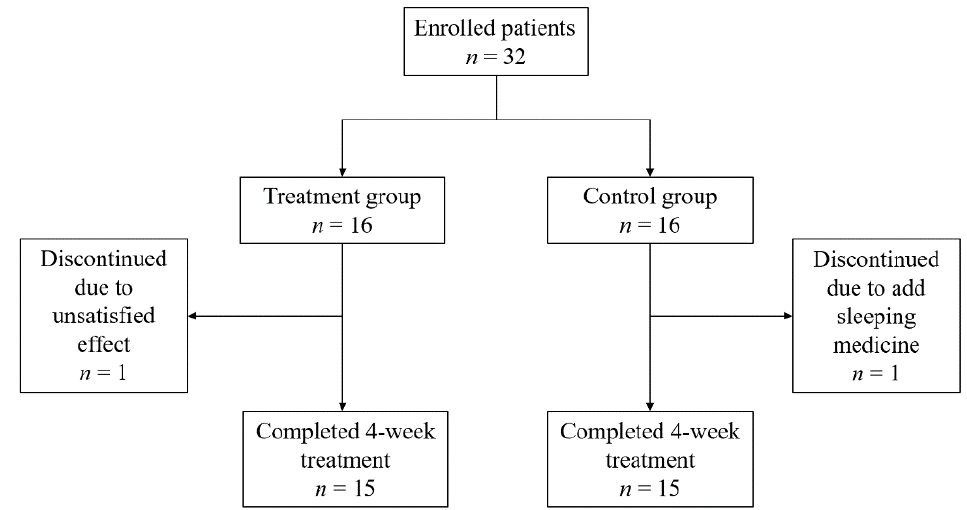
Figure 3. A flowchart of the study. The number of enrolled patients was 32 in total, and equal numbers of patients were randomly grouped into treatment and control groups. One patient in the treatment group discontinued the study due to unsatisfactory effects associated with the therapy, and another patient dropped out from our study because of adding sleeping medicine. Table 1. Comparisons between treatment and control groups, at baseline.